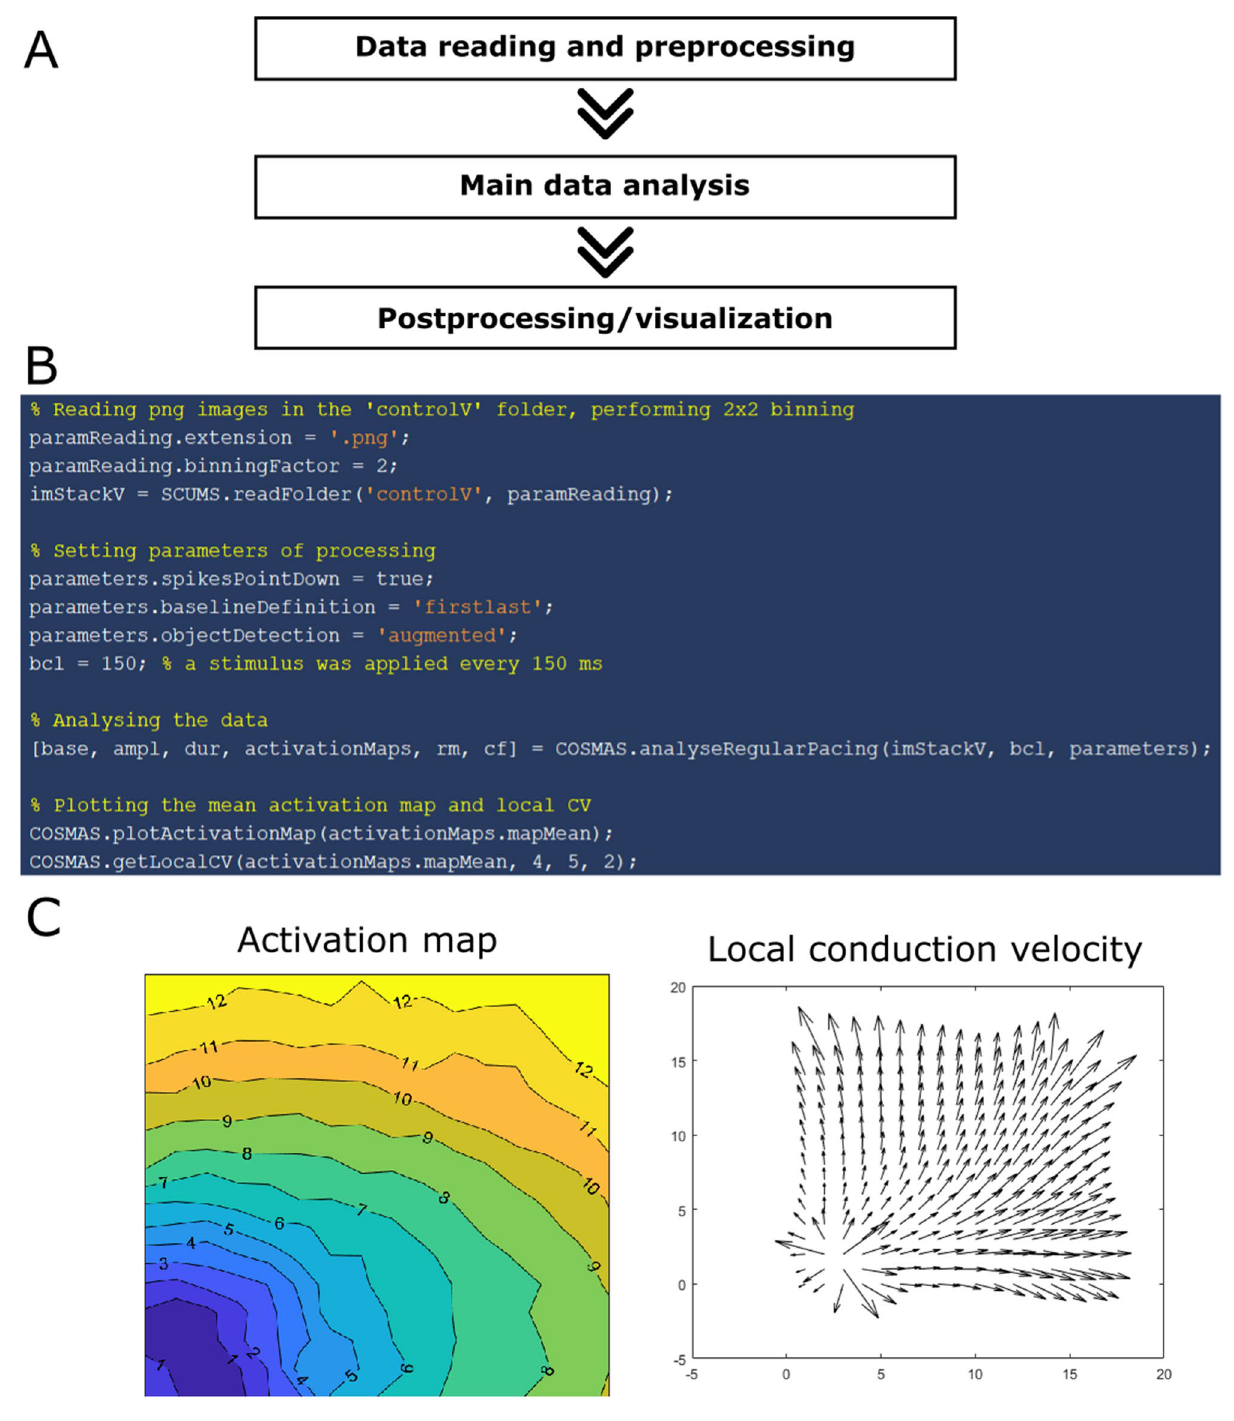
Figure 1. Illustration of COSMAS use. ( A ) General structure of a processing script, ( B ) a concrete example of a script in Matlab, ( C ) the figures produced, showing isochronal activation lines (in ms) and local estimation of conduction